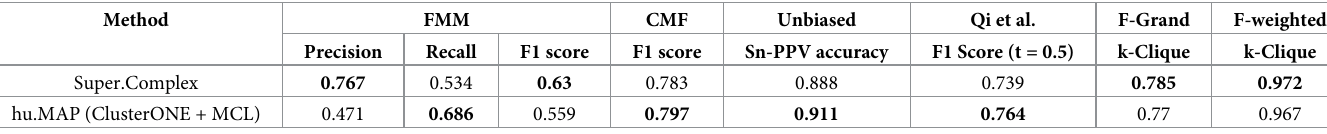
Table 2. Evaluating learned complexes on hu.MAP w.r.t ‘refined CORUM’ complexes.